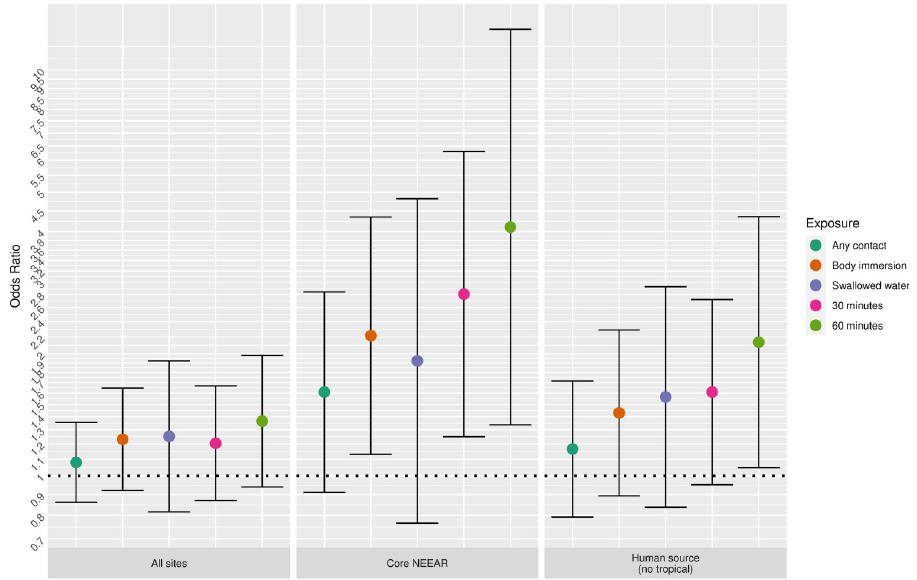
Fig 8. Odds ratios for cough among swimmers associated with a 1-log 10 increase in Enterococcus CFU among children 4 years and under.